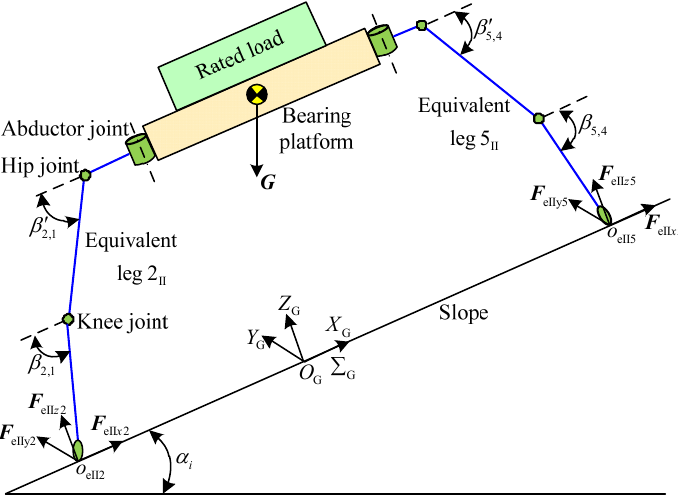
Figure 11. Equivalent model of support phase under working condition II.